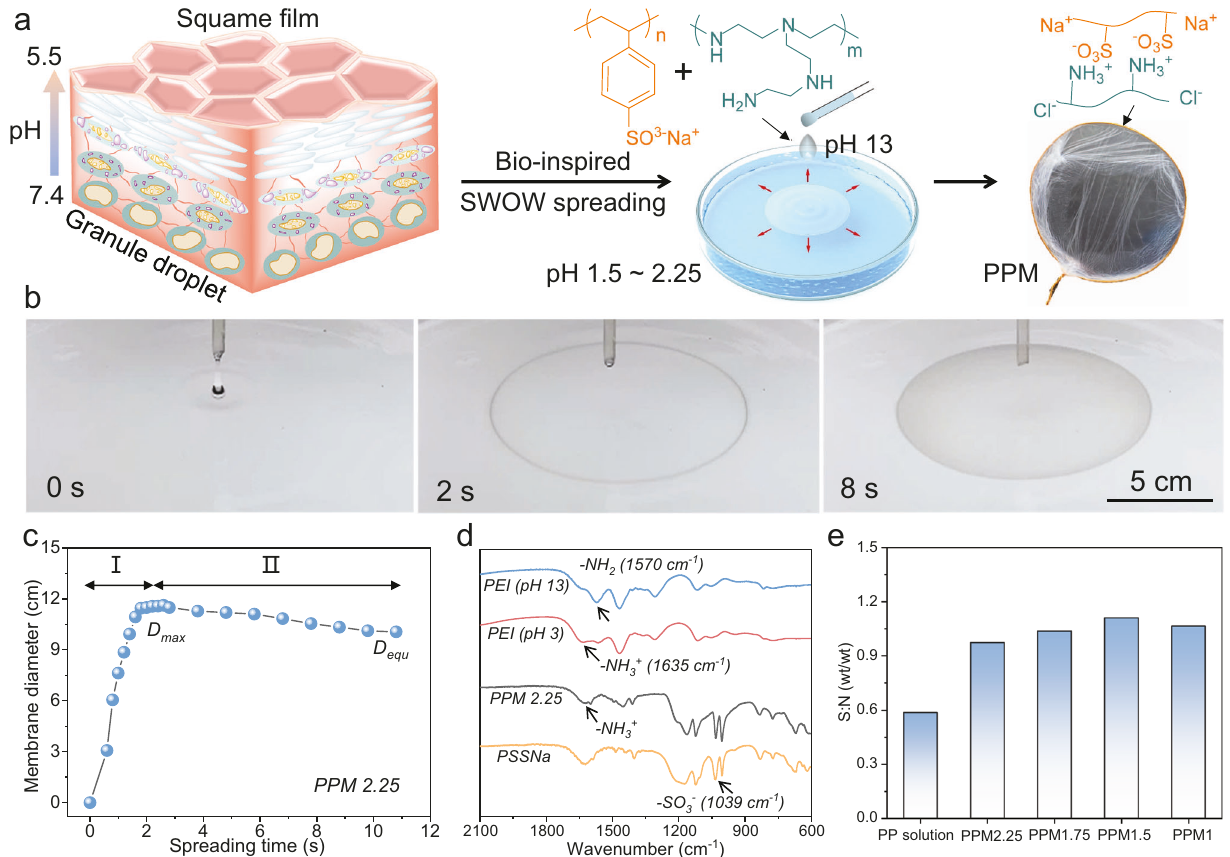
Fig. 1 Bio-inspired preparation of PPMs by SWOW spreading. a Schematic illustration of the formation of skin barriers (left): near the skin surface, the change of intracellular pH value (from 7.4 to 5.5) drives phase separation to form squama. This process inspires the coupling of pH-responsive PEI-PSSNa complexation to water – water interface (right). b Optical photographs of a drop (~40 μ L) of PEI-PSSNa solution spreading on water (pH 2.25, 25 o C). c Effect of spreading time on the diameter of PPM2.25. d FT-IR curves of PPM2.25 and PEI. e Elemental analysis of PPMx (x: 2.25, 1.75, 1.5, 1). Note: PP means PEI-PSSNa